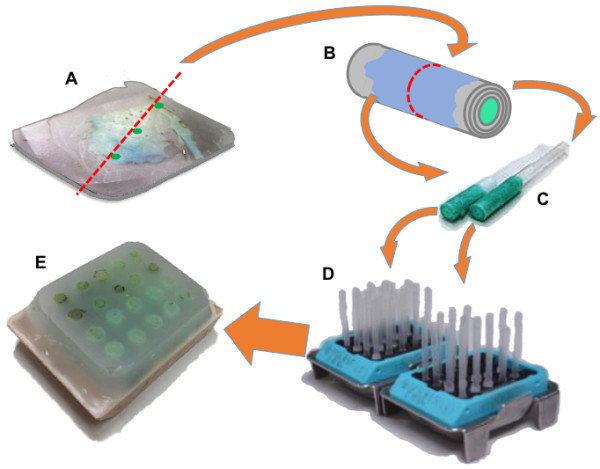
Schematic figure indicating composition process of Spiral Array. A) 100 μm-thick sections are cut from the donor blocks. B) The sections are then reeled on the plastic core. C) The subcylindrical cores were cut in the center of the reel. D) Each subcylindrical reel was vertically inserted into a tissue-holding-cassette. E) By pouring a melted paraffin, Spiral Array block is completed.